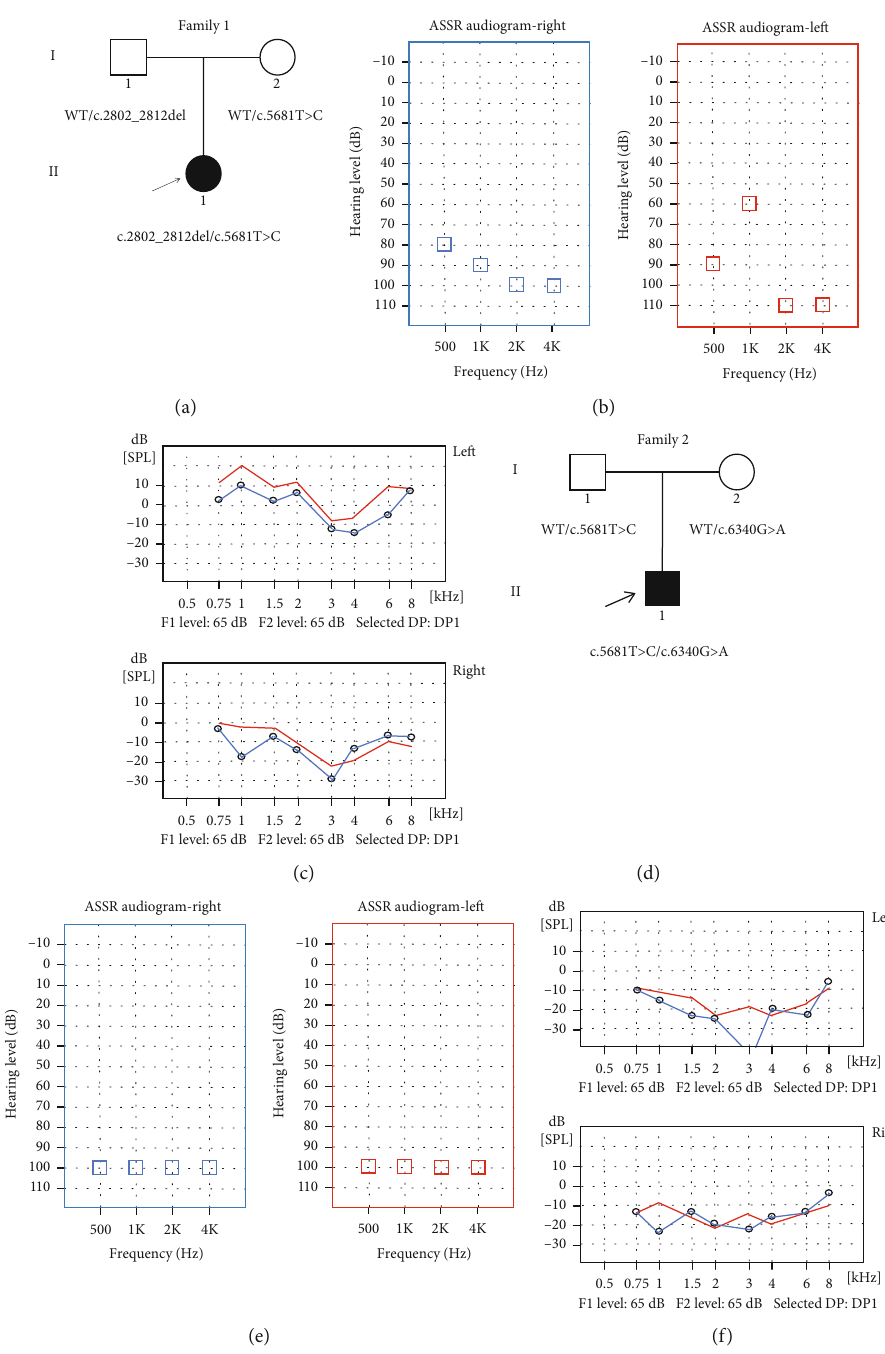
Figure 1: Pedigrees of the a ff ected Family 1 (a) and Family 2 (d) associated with NSHL. The novel compound heterozygous mutations were found in family members. The probands are shown in black. WT: wild type. (b) Auditory steady-state response (ASSR) audiogram of the proband II-1 of Family 1. (c) Distortion product otoacoustic emission (DPOAE) audiogram of both ears of the proband II-1 of Family 1. (e) ASSR audiogram of the proband II-1 of Family 2. (f) DPOAE audiogram of both ears of the proband II-1 of Family